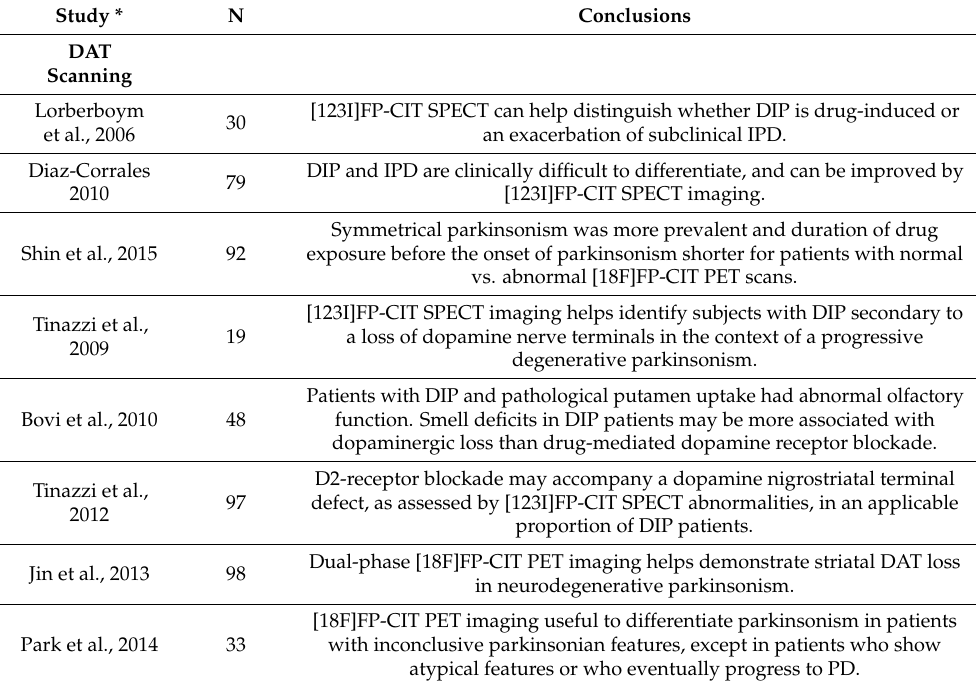
Table 7. Studies on investigations for the differential diagnosis of DIP vs.